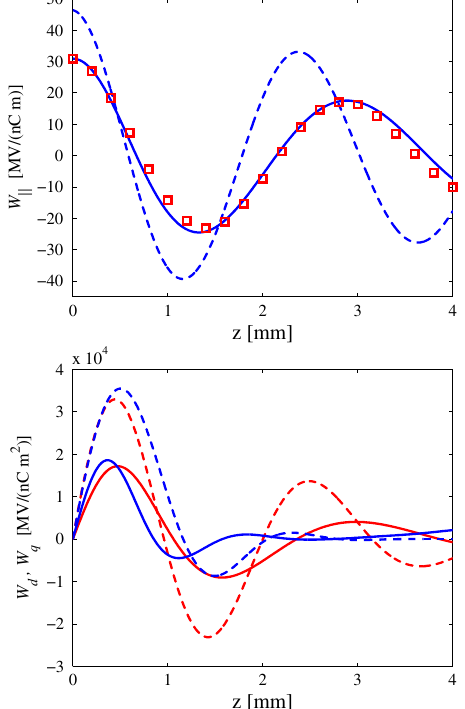
FIG. 3. (Up) wave numbers and (down) loss factor of longi- tudinal wake and kick factor of dipole and quadrupole wake for horizontal mode number l for nominal LCLS dechirper param- eters, with a ¼ 0 . 7 mm.